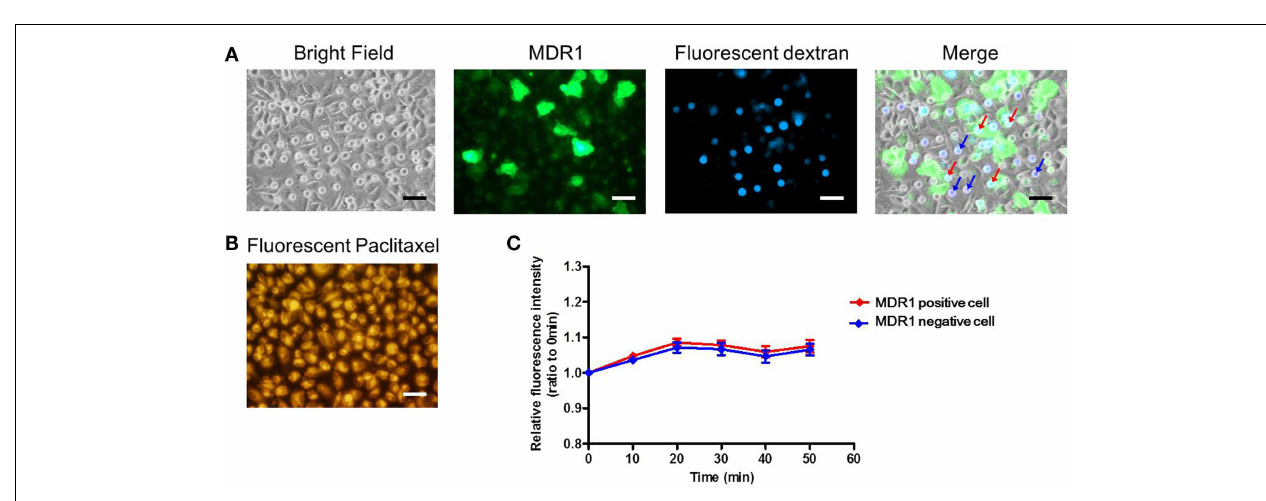
microchamber for MDR1 positive (red line) cells and MDR1 negative cells (blue line) both retaining dextran. Each line represents the average of four independent chambers indicated by the arrows with corresponding colors in the merged image. Data are presented as the mean ± SEM and significance was assessed using the Student’s t -test. All scale bars in micrographs represent 50 µ